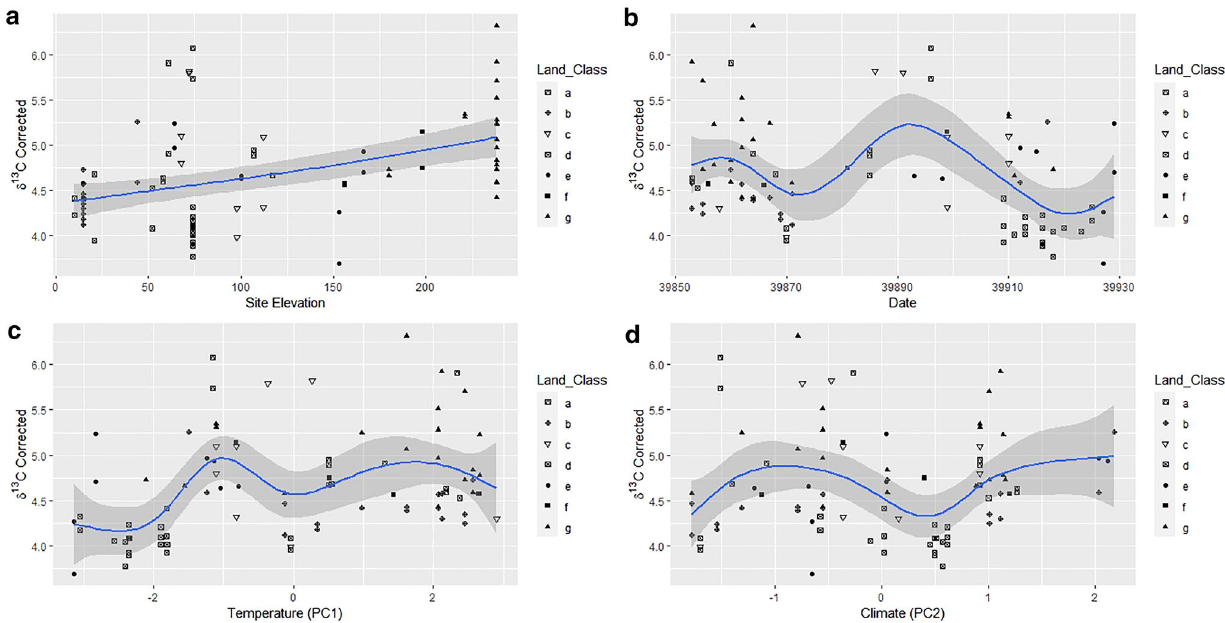
Figure 7. GAM factors smoothed for the hair dataset. Uncorrected δ 15 N versus ( a ) Site Elevation, ( b ) Date, ( c ) Temperature PC1, and ( d ) Climate PC2. Solid lines indicate the trend line, and the shaded area is the approximate 95% point-wise confidence interval.